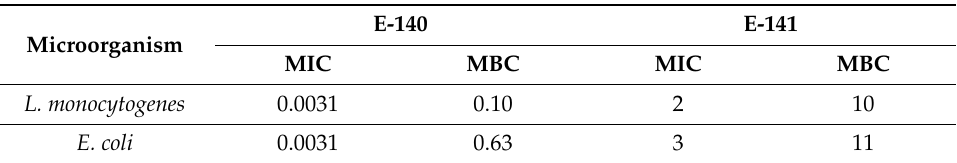
Table 1. Minimum inhibitory concentration (MIC in mg/mL) and minimum bactericidal concentration (MBC in mg/mL) of chlorophyllins E-140 and E-141 against L. monocytogenes and E. coli activated by halogen light (15 min).